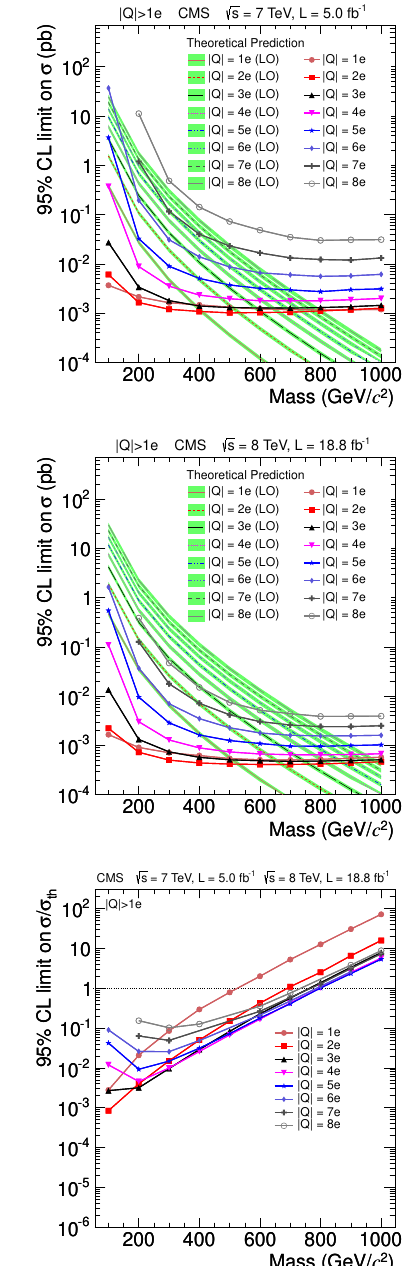
Theoretical Prediction |Q| = 2e/3 (LO)